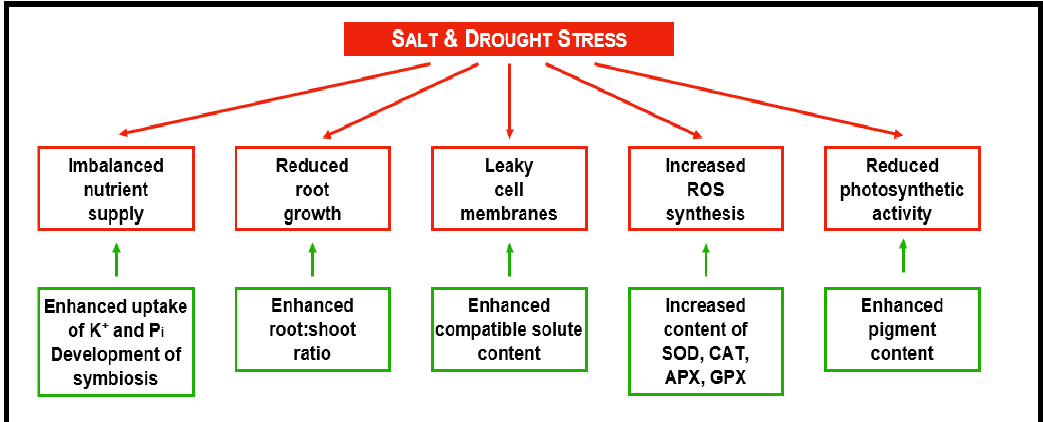
Figure 7. An overview of responses to salt and drought stress. Responses observed under stress are boxed in red. Green boxes are listing strategies successfully used by stress-tolerant accessions of investigated plant species to avoid adverse effects of stress. Not all of the listed strategies are used by an individual plant. The preferred response of a plant species depends on the respective genetic potential. Moreover, responses may be scaled depending on the developmental and nutritional state of a plant when exposed to stress.